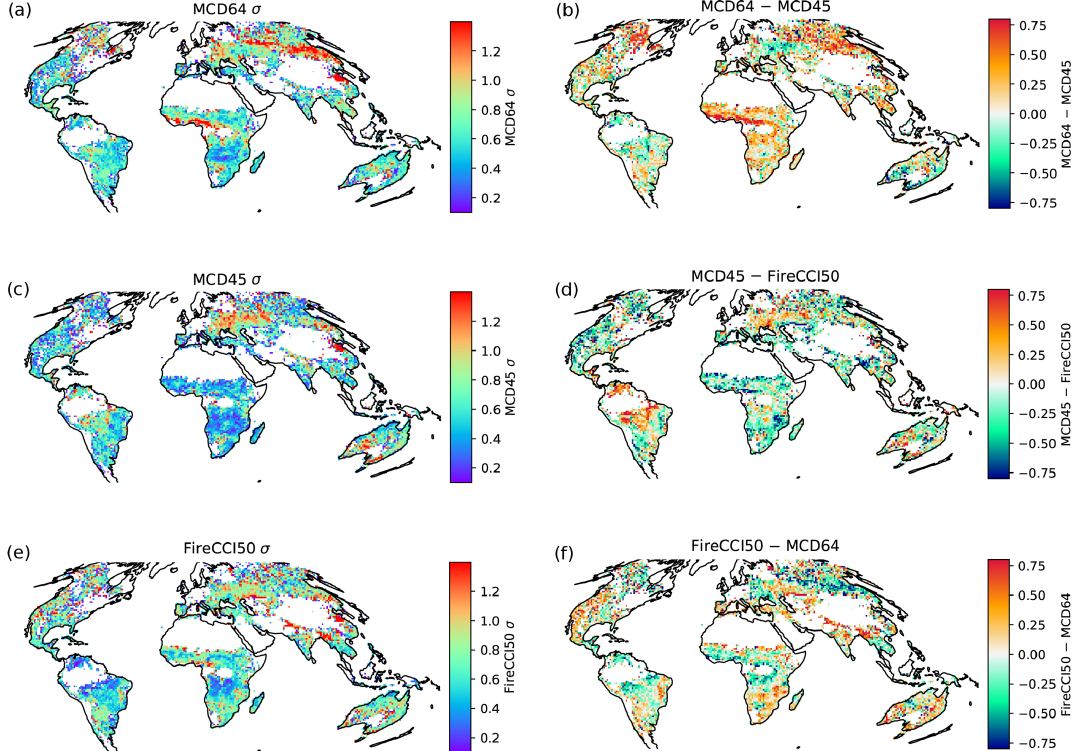
Figure 4. (a, c, e) TC random errors for the three products and (b, d, f) differences between product random errors.